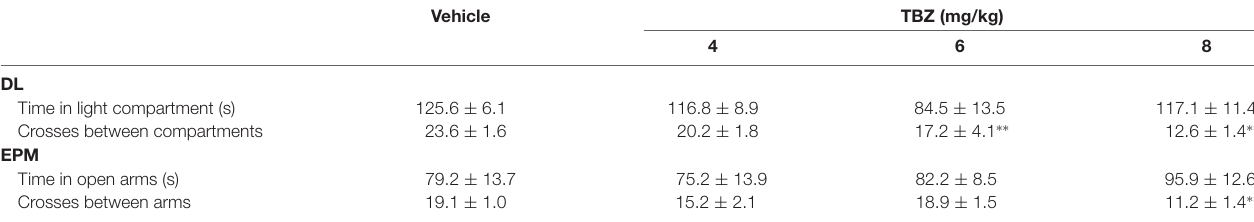
TABLE 3 | Effect of tetrabenazine (TBZ) on mice behavior in the dark-light (DL) box and elevated plus maze (EPM).